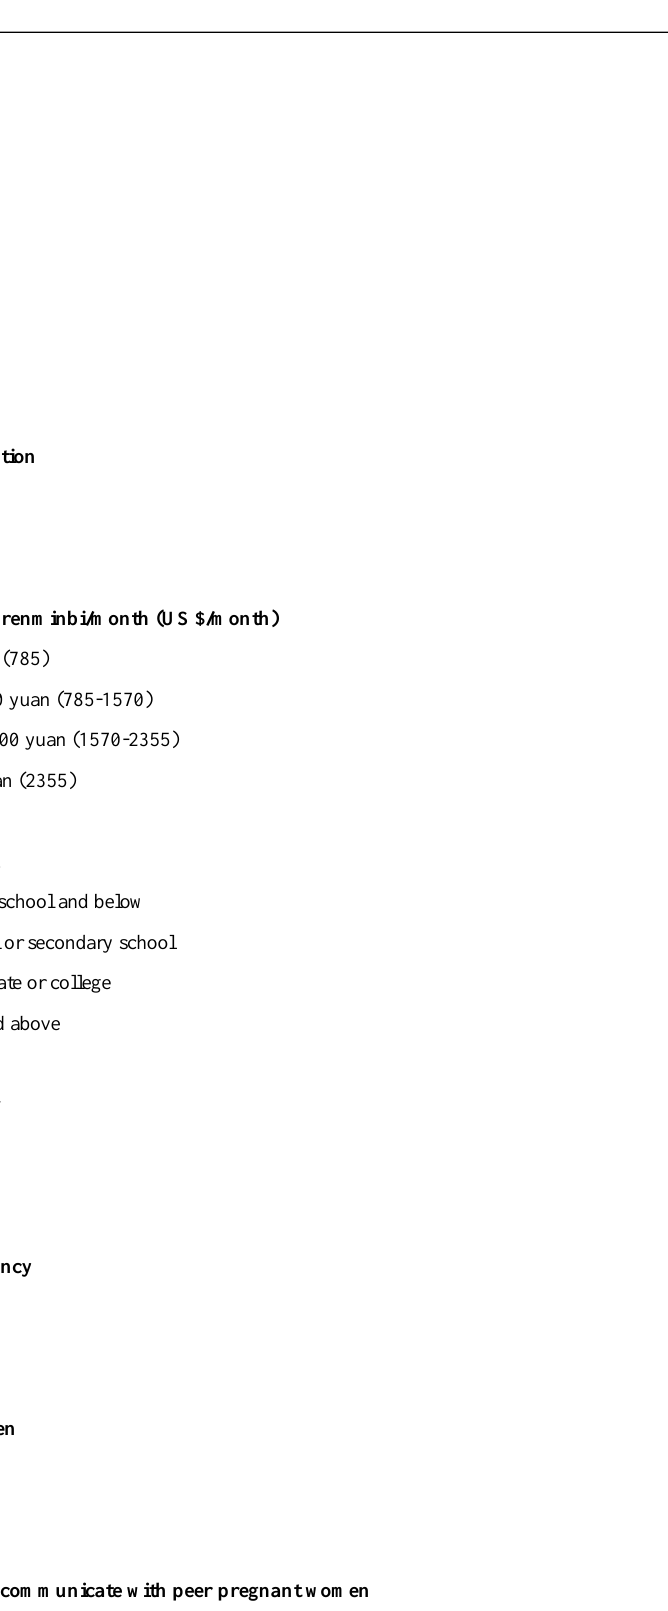
Table 1. Demographic information of pregnant